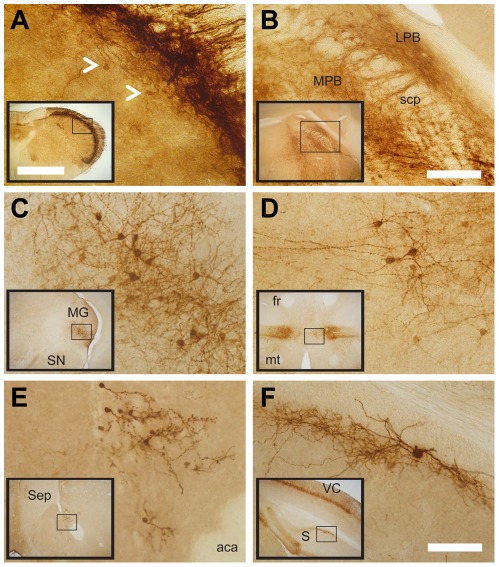
CGRPα-GFP labels neurons and axons in specific brain regions.(A–F) Brain sections from CGRPα-GFP+/− mice were stained with antibodies to GFP. (A) Trigeminal spinal nucleus caudalis. Arrowheads point to labeled cells in lamina III, similar to those shown in Figure 4A–F. (B) Parabrachial nucleus. (C) Peripeduncular and posterior intralaminar thalamic nuclei. (D) Subparafascicular nucleus of the thalamus. (E) Nucleus accumbens. (F) Subiculum. Abbreviations: LPB = lateral parabrachial nucleus; MPB = medial parabrachial nucleus; scp = superior cerebral peduncle; MG = medial geniculate; SN = substantia nigra; fr = fasciculus retroflexus; mt = mammillothalamic tract; Sep = septum; aca = anterior commissure, anterior; S = subiculum; VC = visual cortex. Inset in each panel shows a lower magnification view. Scale bar in (A) inset is 1 mm and applies to all insets; (B) is 200 µm and applies to (B); (F) is 100 µm and applies to (A,C–F).